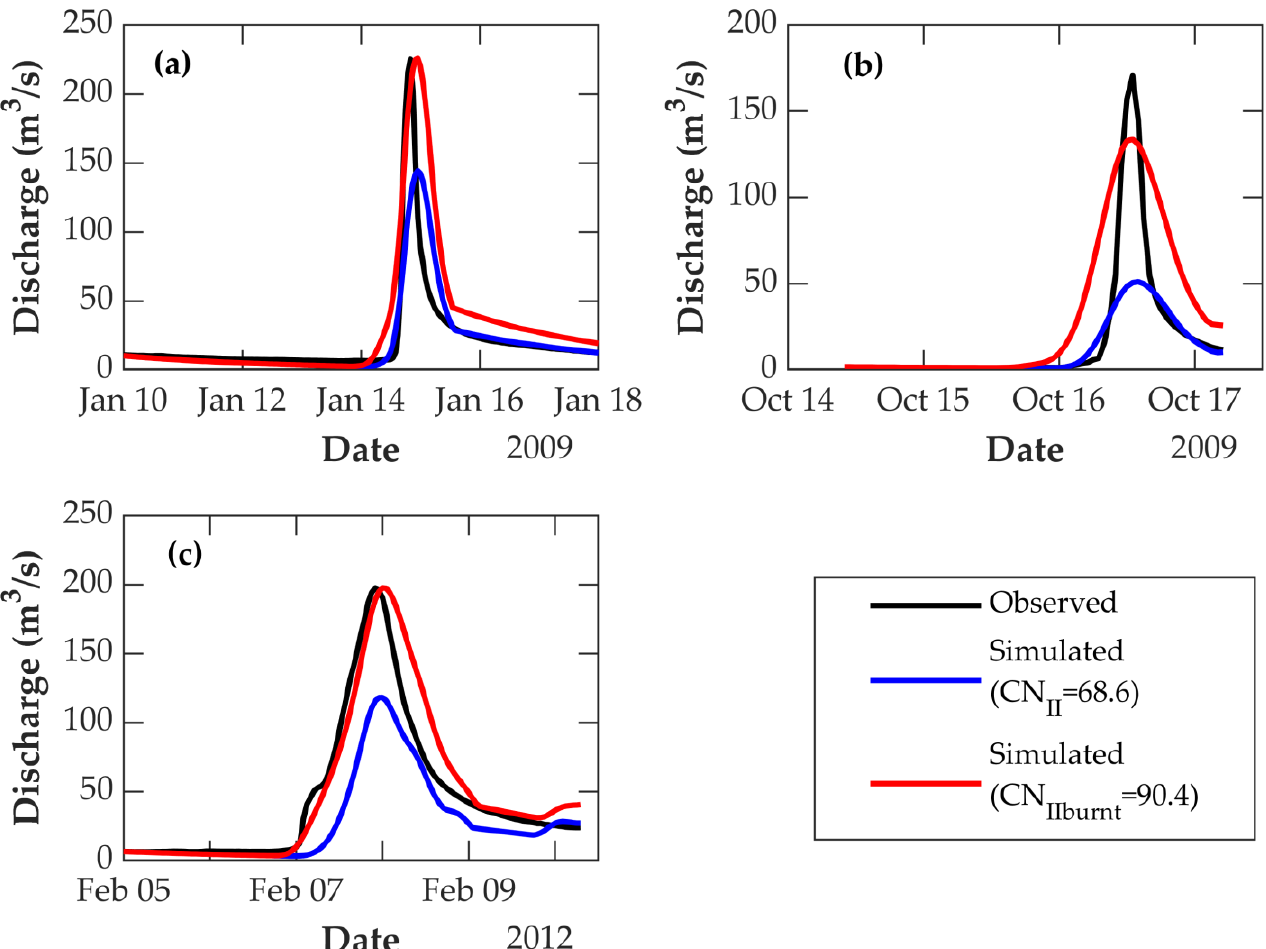
Figure 8. Comparison of the observed hydrograph simulation for different values of Curve Number: ( a ) Flood event in 9 January 2009–18 January 2009; ( b ) flood event in 14 October 2009–17